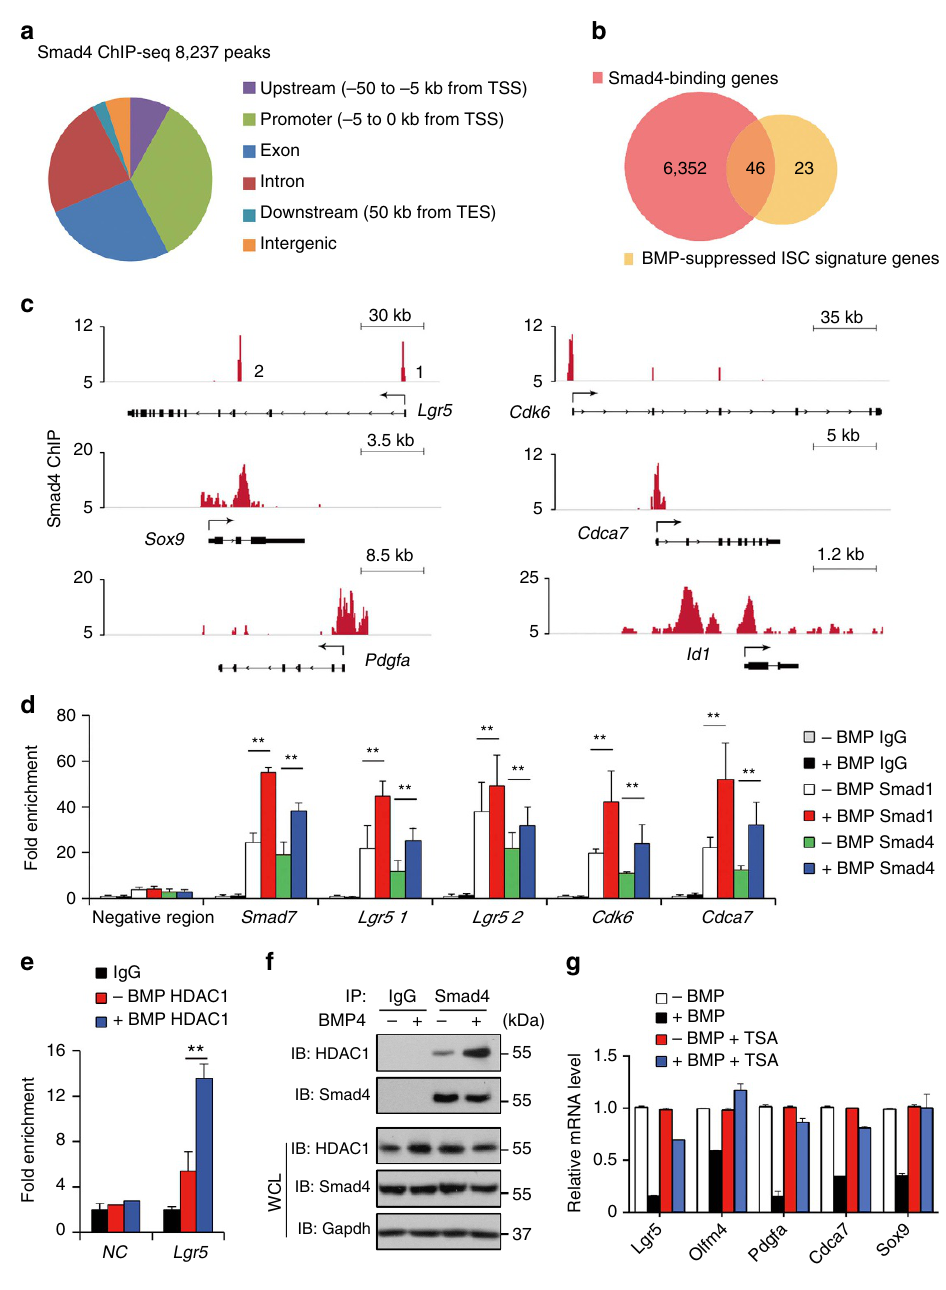
Figure 5 | Smad proteins bind to the promoter regions of stem cell signature genes and recruit HDAC1 to repress transcription. ( a ) Genome-wide distribution of Smad4-binding sites in Lgr5 þ stem cells. TES, transcription end site; TSS, transcription start site. ( b ) Venn diagram showing the overlap between BMP-downregulated signature genes with Smad4 bound genes. P ¼ 6.00E-12. ( c ) ChIP-seq signals for Smad4 binding at the representative genomic loci. Id1 served as a positive control. ( d ) Lgr5 þ stem cells were stimulated with or without BMP4 for 4h and subjected to ChIP assays with anti- Smad1, anti-Smad4 antibodies or control IgG. Quantitative RT–PCR followed ChIP shows the enrichment of Smad1 or Smad4 in the promoter or enhancer regions of indicated genes. Smad7 served as positive control. Data represent mean ± s.e.m of three independent experiments. ** P o 0.01 by Student’s t -test. ( e ) HDAC1 ChIP assays in Lgr5 þ stem cells with or without 4h BMP4 treatment. Data represent mean ± s.e.m of three independent